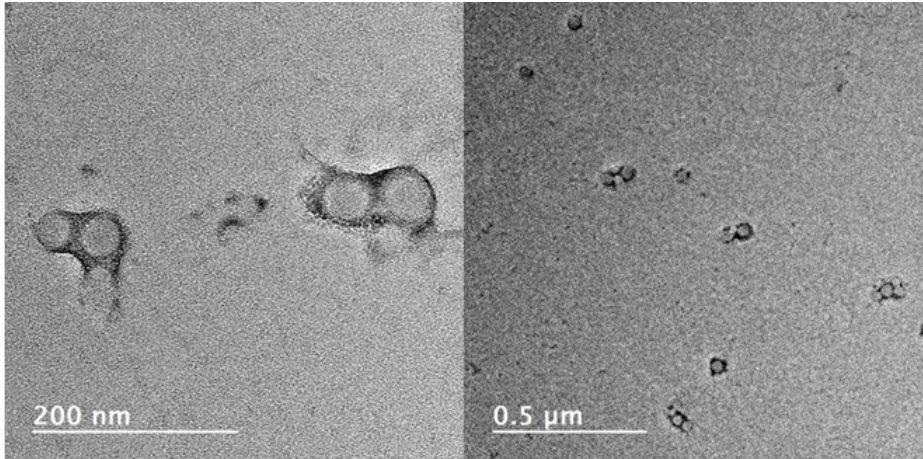
Figure 3. TEM images of the PMLABe 73 NPs obtained at a stirring rate of 1200 rpm, a polymer concentration of 5 mg/mL, an addition rate of 55.14 mL/h and a THF:water ratio of